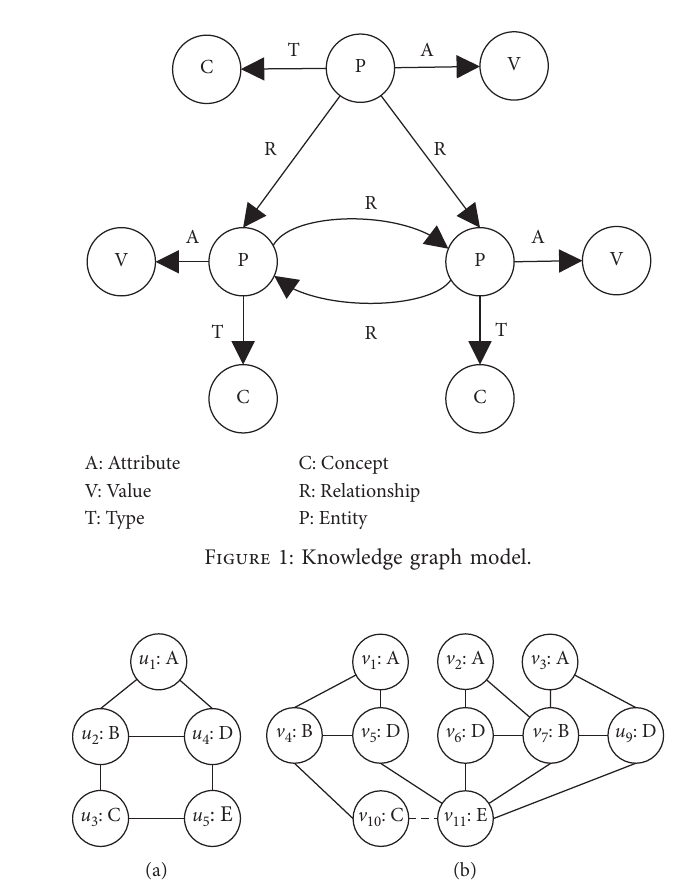
Figure 2: Continuous subgraph matching. (a) Query graph. (b) Data graph.